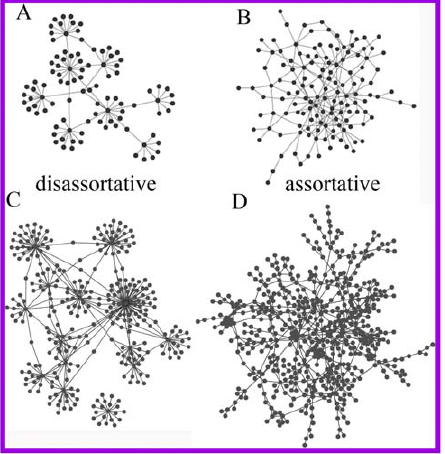
Figure 1. Disassortative and assortative networks. Schematic illustration of a disassortative network ( A ) and an assortative network ( B ). C . The 15 best connected proteins and their direct links to other proteins of yeast protein network constructed by proteins localized in nucleus. D . The rest of network after removal of the 15 best connected nodes. Nodes disconnected to the largest component are not shown. A predominant feature of B and D is the over-abundance of links between low connected